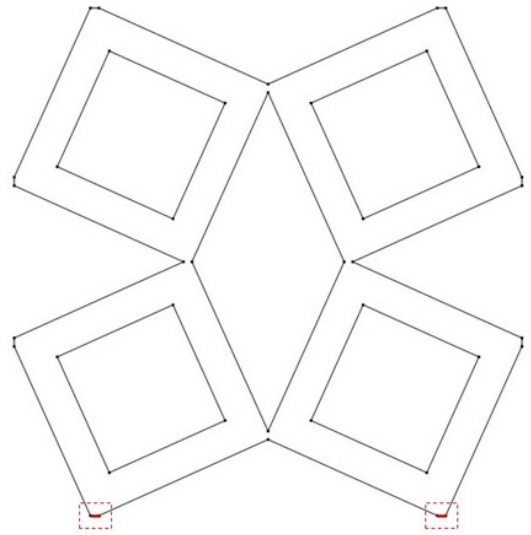
Figure 12. Considered load scenario for evaluation of effective structure properties. Free boundary condition is applied for the remaining boundaries.